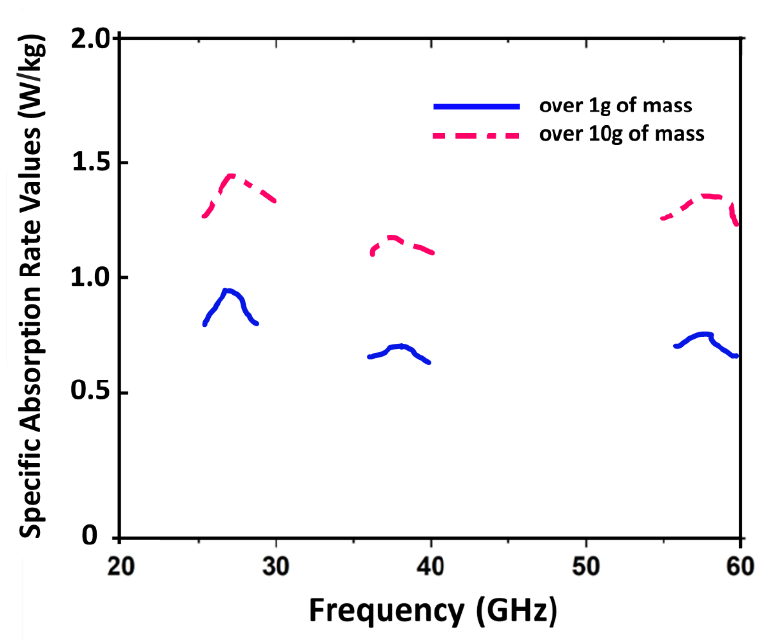
Figure 13. SAR values vs. frequency graph over phantom using mathematical equations.